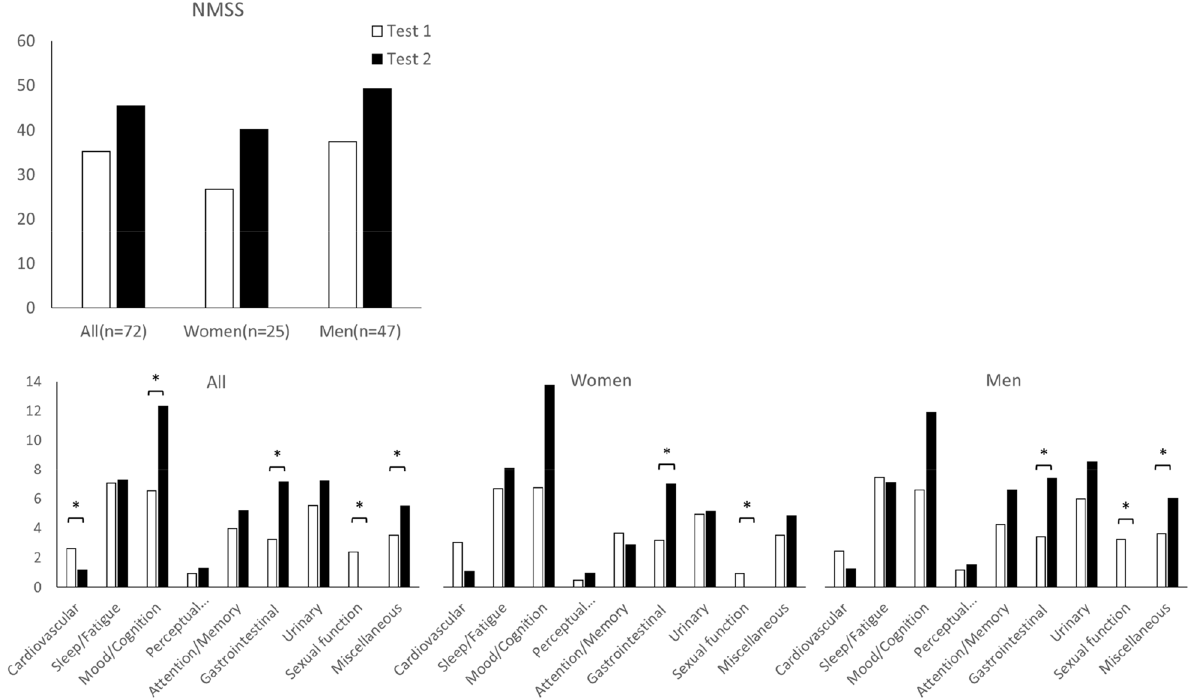
Figure 3. The evolution of NMSS and each domain in 6 years. Test 1 is the baseline data and Test 2 is the follow-up data. Wilcoxon signed rank test was used. P value < 0.017 indicated significance and was marked *. The upper figure showed the trend of NMSS and lower three figures showed the trend of each domain in all patients, women and men.